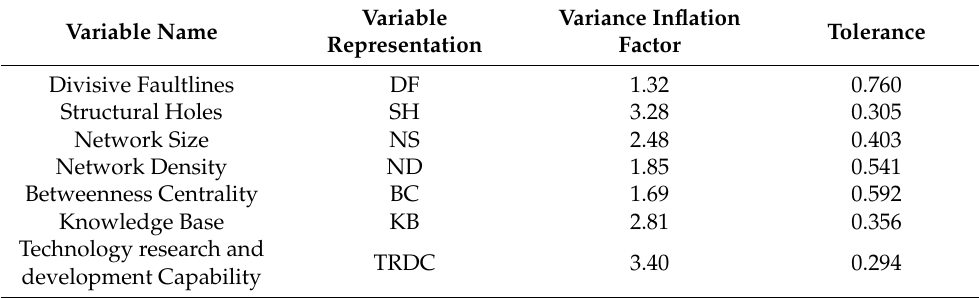
Table 2. Multicollinearity